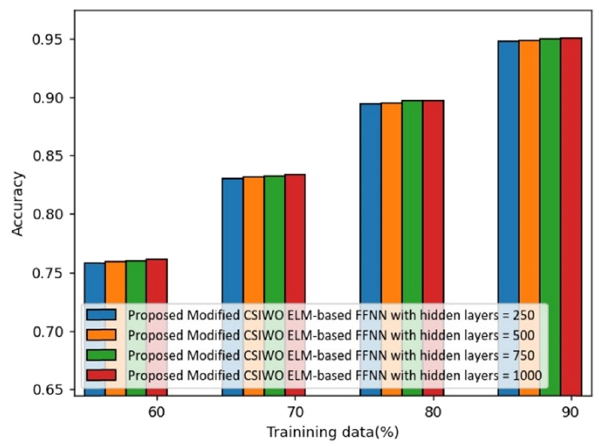
Figure 2: Analysis of the developed method based on accuracy ( Cleveland dataset ) .